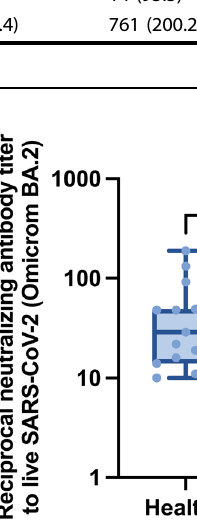
Fig. 2 Neutralizing activity against the Omicron BA.2 variant were evaluated using PRNT. Inhibition (%) of SARS ‐ CoV ‐ 2 binding to the human host receptor angiotensin-converting enzyme ‐ 2 at 1-month after vaccination with CoronaVac (SV) followed by ChAdOx1 nCoV- 19 (Oxford-AstraZeneca; AZ) in patients with SARDs and healthy group. Each symbol represents one participant, and the line denotes the median for each group ( n = 15) with the 95% CI. Statistical signi fi cance was determined using the Mann – Whitney test. ** p ≤